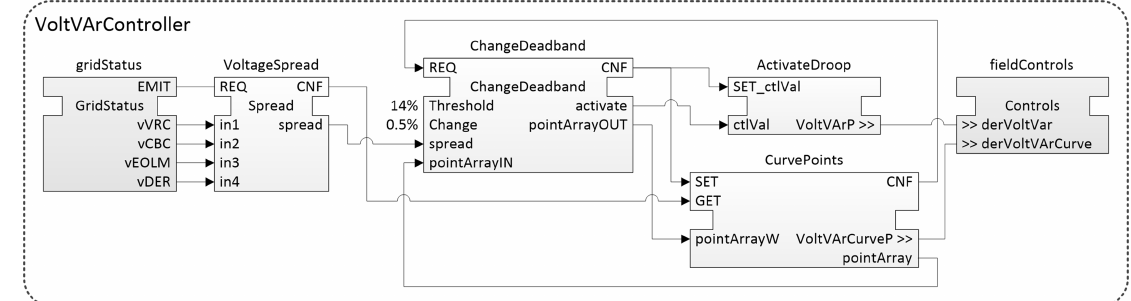
Figure 21. Implementation of the VoltVArController application in IEC 61499